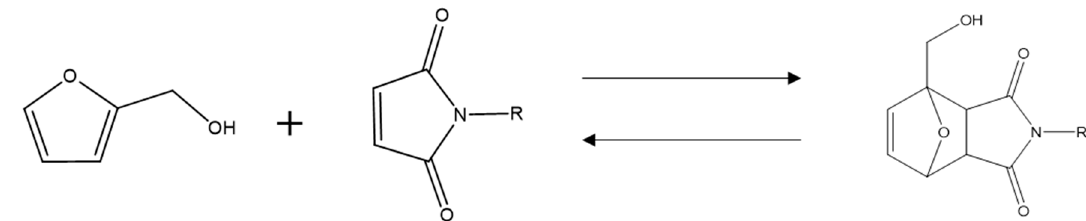
Scheme 1. Reaction of furfuryl alcohol (FA) and selected maleimides. R = OH. R = CH 2 CH 2 OH.